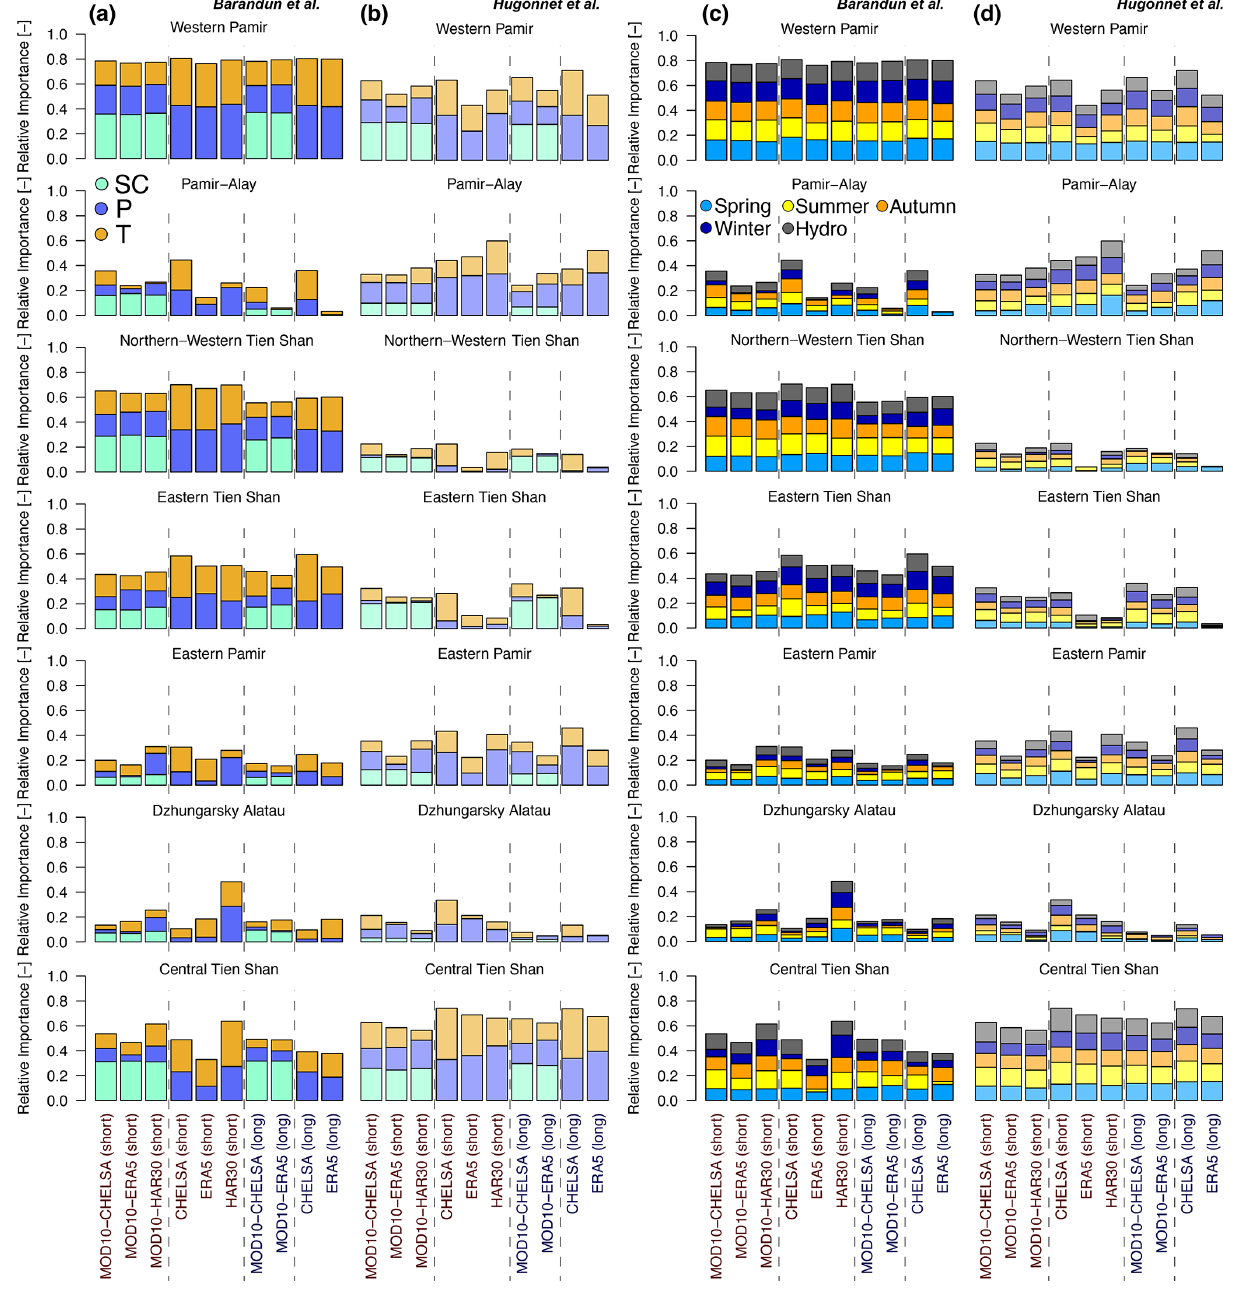
Figure 7. Importance of (a, b) meteorological variables and (c, d) seasons as the number of significant correlations identified using mass balance estimates from Barandun et al. (2021a) (solid color) and from Hugonnet et al. (2021) (semitransparent color) for the HIMAP regions. Labels short and long refer to the periods 2000–2014 and 2000–2018,